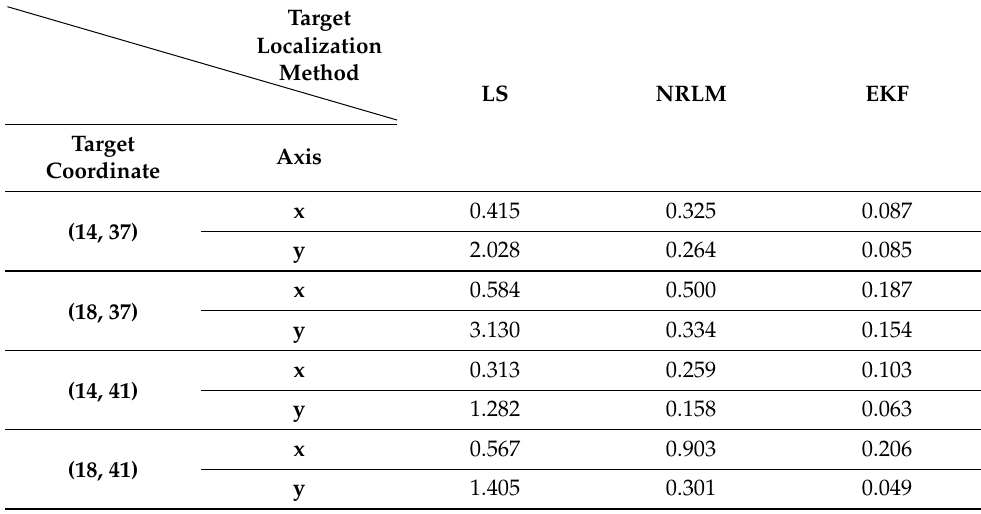
Table 3. Case 1—Standard deviations of target coordinates ( X , Y ) for the marker pen (unit: cm).